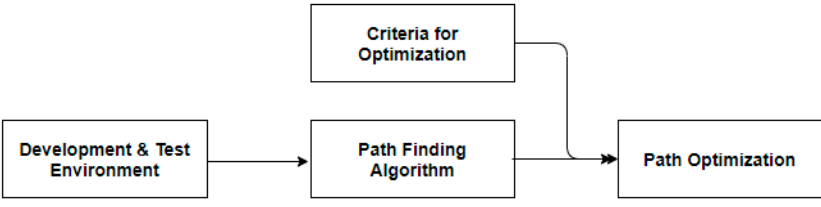
Figure 2. Development steps for global/local path optimization [13].